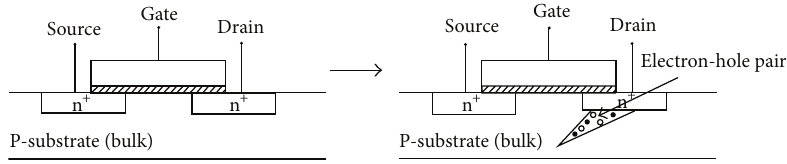
Figure 1: An illustration of how alpha particles strike a MOSFET device